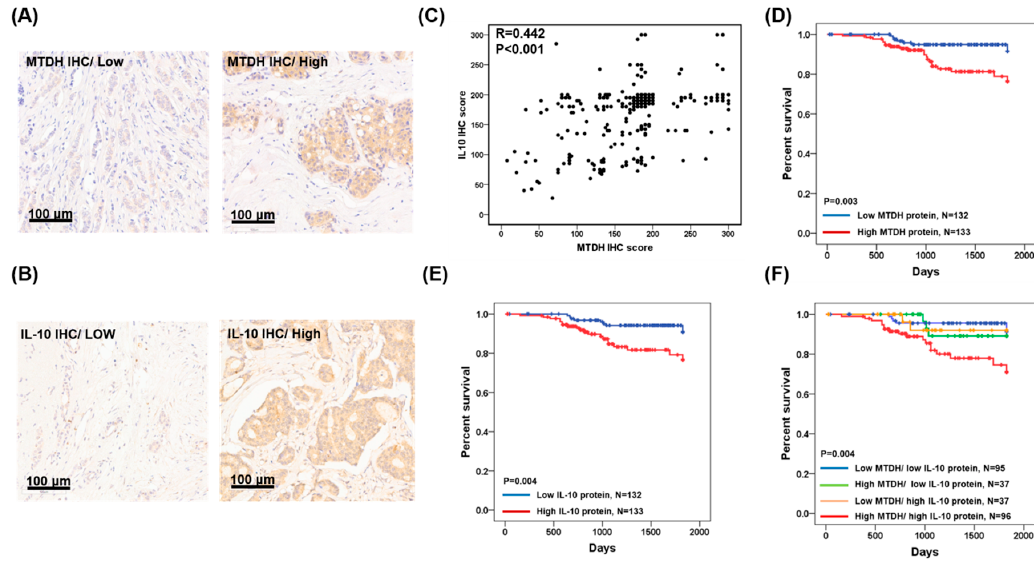
Figure 3. MTDH and IL ‐ 10 protein expression in tumor tissues of breast cancer patients, and Kaplan– and Kaplan–Meier analysis of MTDH and IL-10 protein expression for breast cancer patients. Meier analysis of MTDH and IL ‐ 10 protein expression for breast cancer patients. ( A ) Representative low and high MTDH immunostaining results in breast cancer tissues. ( B ) Representative low and high IL ‐ 10 immunostaining results in breast cancer tissue. ( C ) Pearson’s correlation used to elucidate